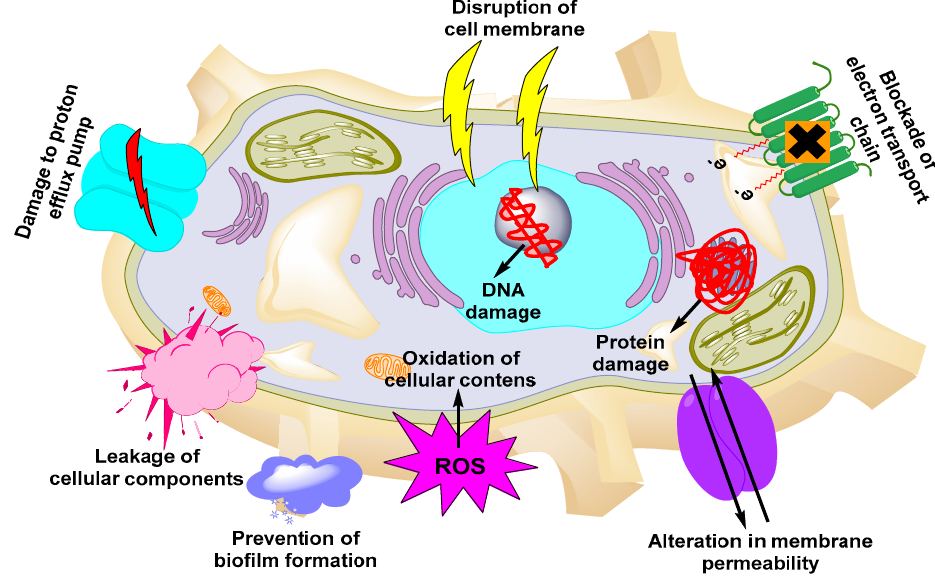
Figure 2. Mechanisms of action of metallic NPs against